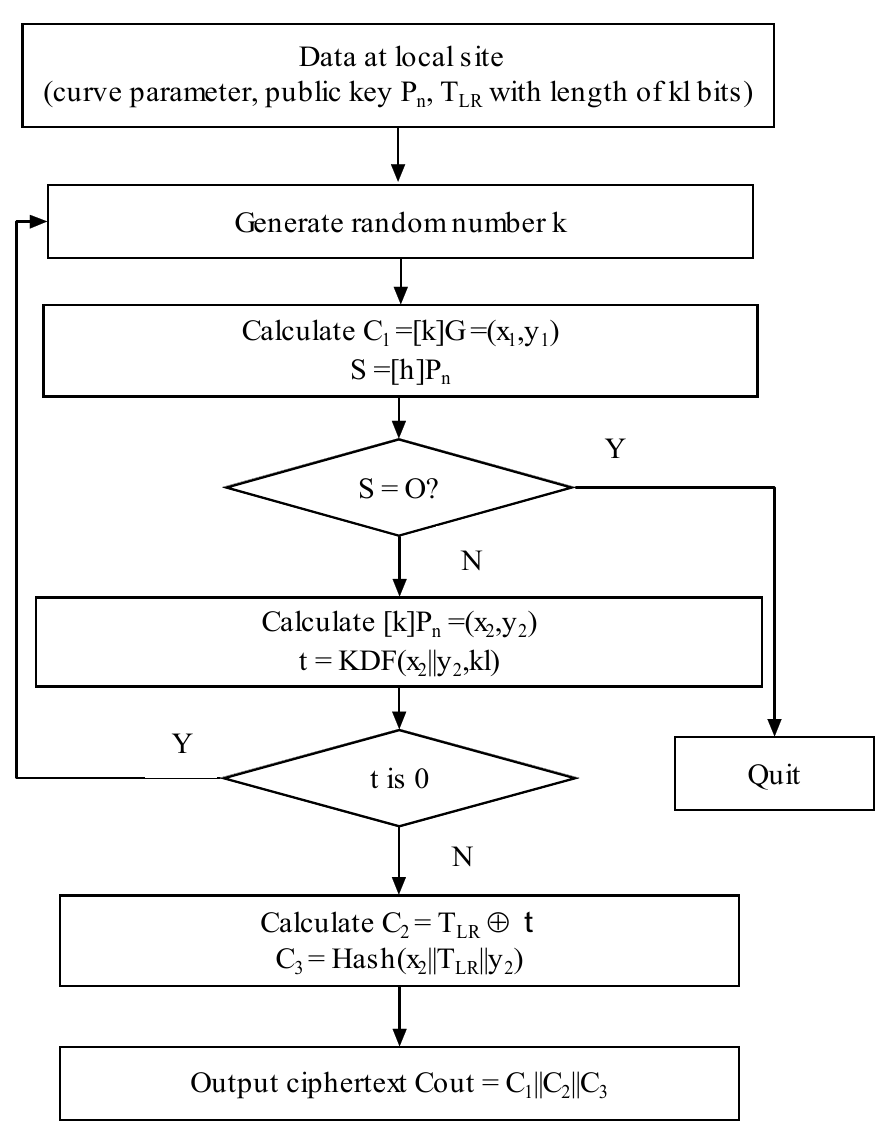
Figure 2. SM2 encryption algorithm.